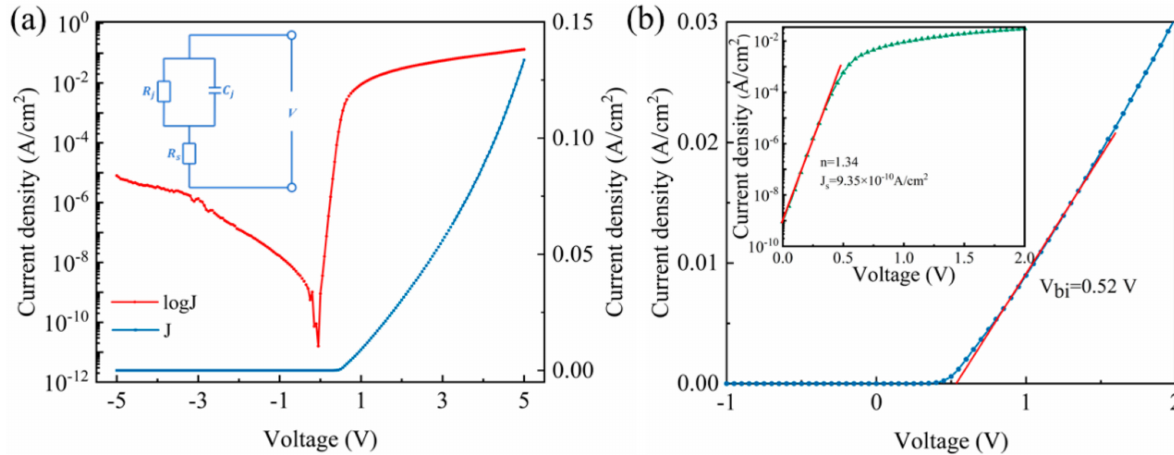
Figure 3. ( a ) The current density–voltage (J–V) curves of the Ni/Ga 2 O 3 /Ti Schottky diode, inset is the equivalent circuit diagram, ( b ) the n , J s , and V bi based on thermionic emission (TE) model.